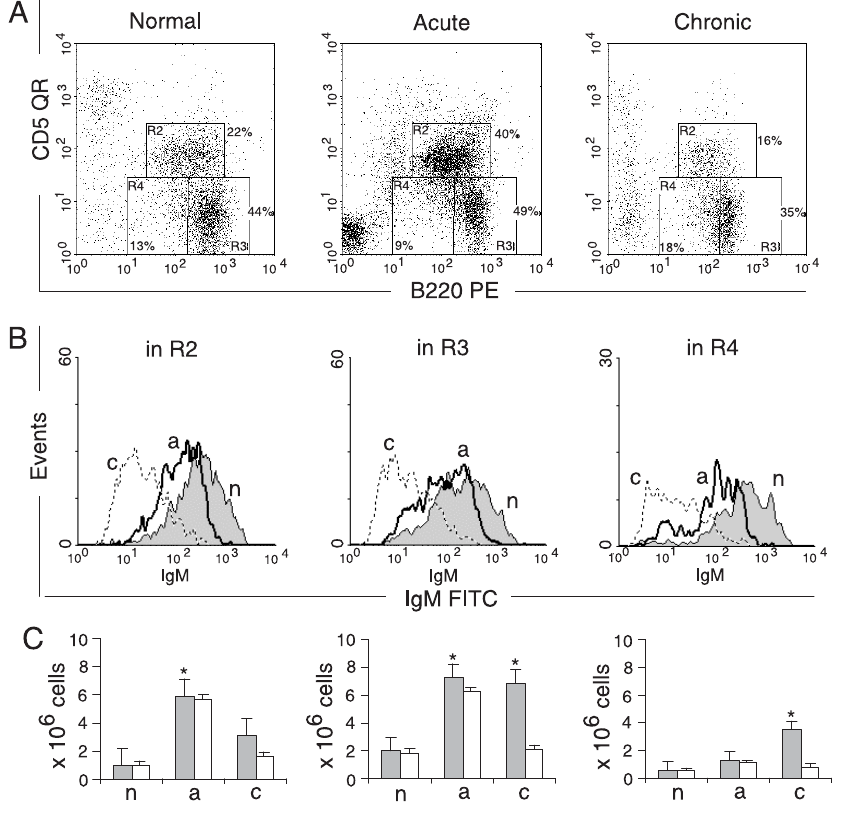
Figure 5. Surface expression of B220, CD5 and IgM on cells from the peritoneal cavity. A , Dot plot of cells in the lymphocyte gate. The R2, R3 and R4 re- gions represent the B1a, B2 and B1b cells, respectively. B , Inten- sity of IgM on the B-cell